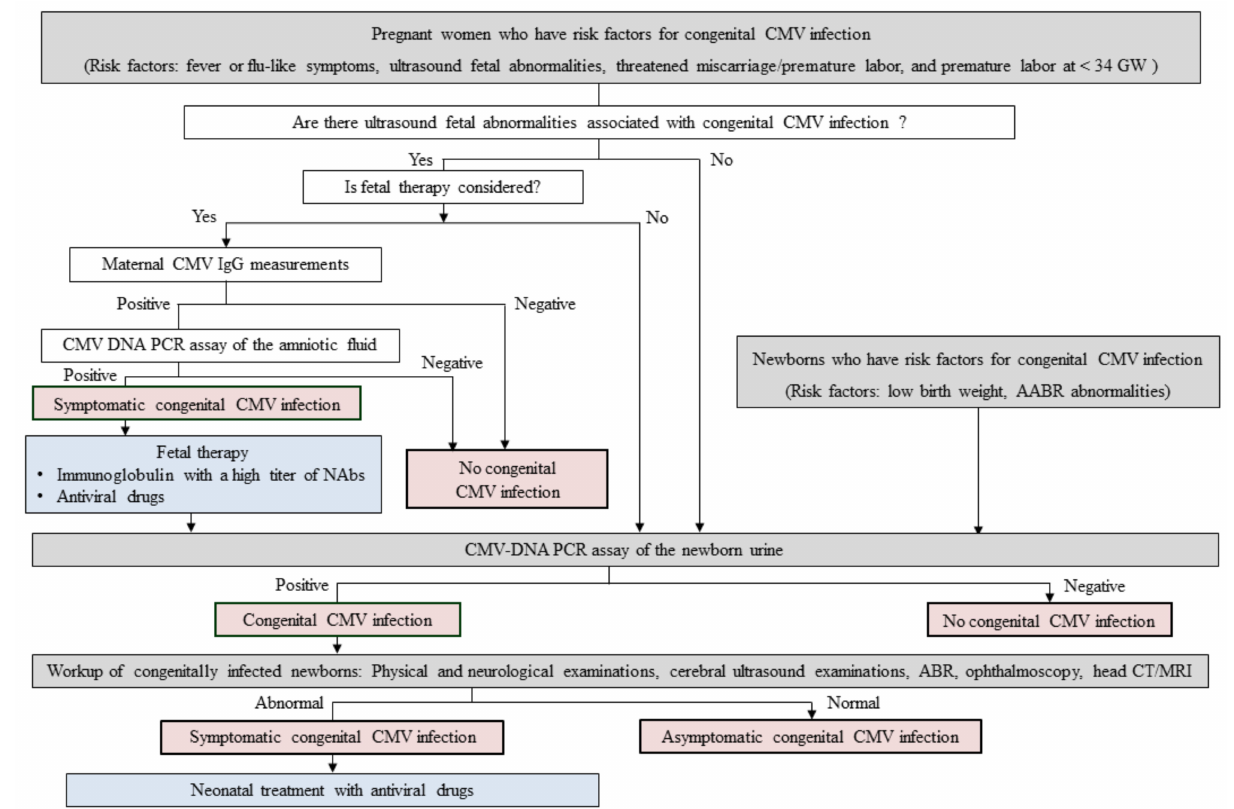
Figure 1. An example of a flow algorithm of potential screening and treatment for congenital CMV infection based on our recent